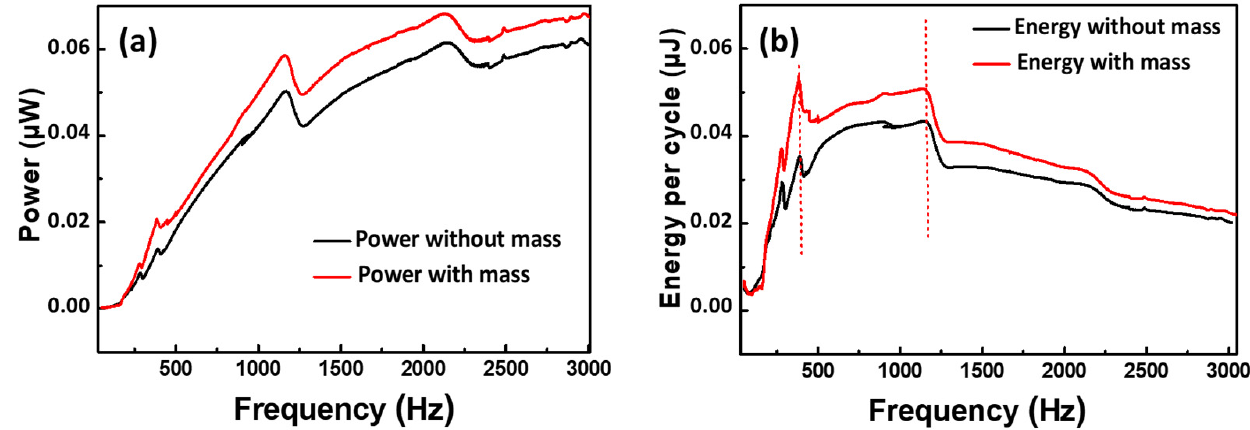
Figure 6. ( a ) Variation of instantaneous power, with and without mass (2 g). ( b ) Variation of energy per cycle as function of vibrational frequency, with and without mass (2